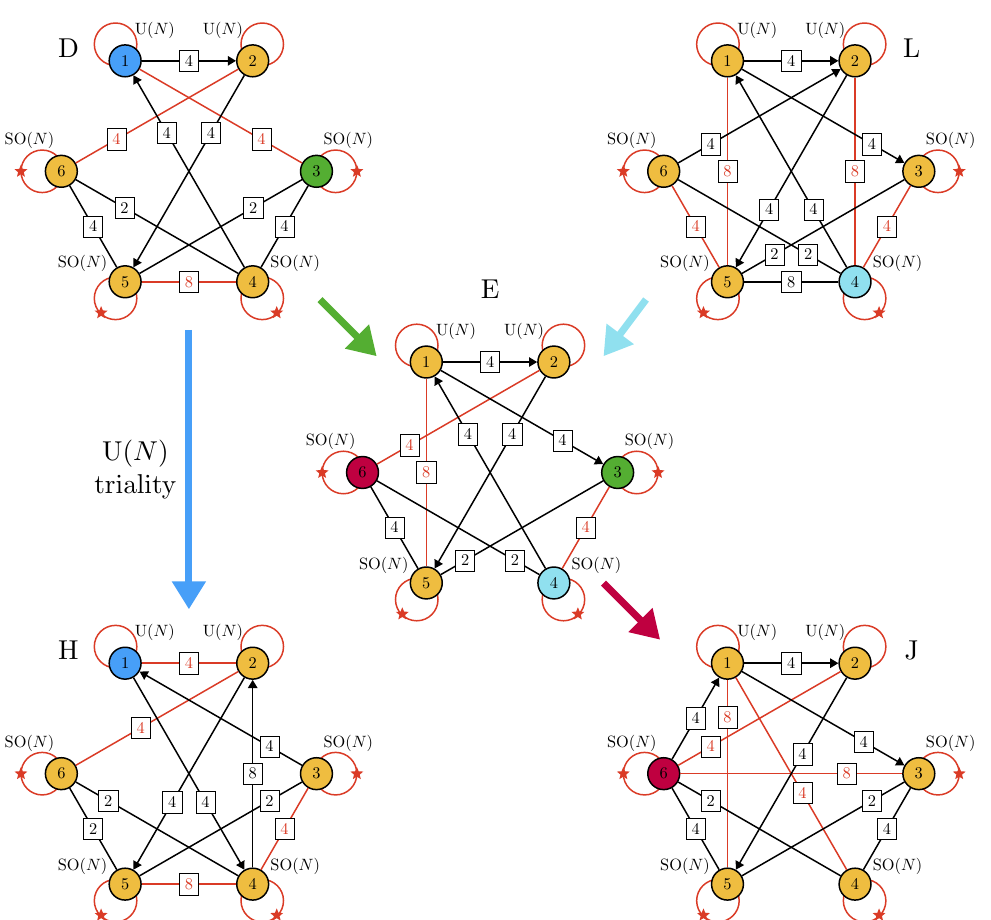
Figure 23 . Triality web for the N = (0 , 1) theories associated with the Spin(7) orientifolds under consideration for phases D, E, H, J and L of Q 1 , 1 , 1 / Z